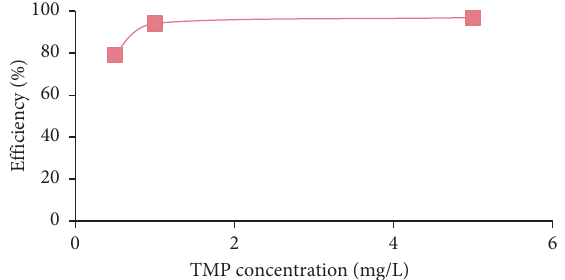
Figure 6: Effect of initial TMP concentrations on the UV/ZnO process.